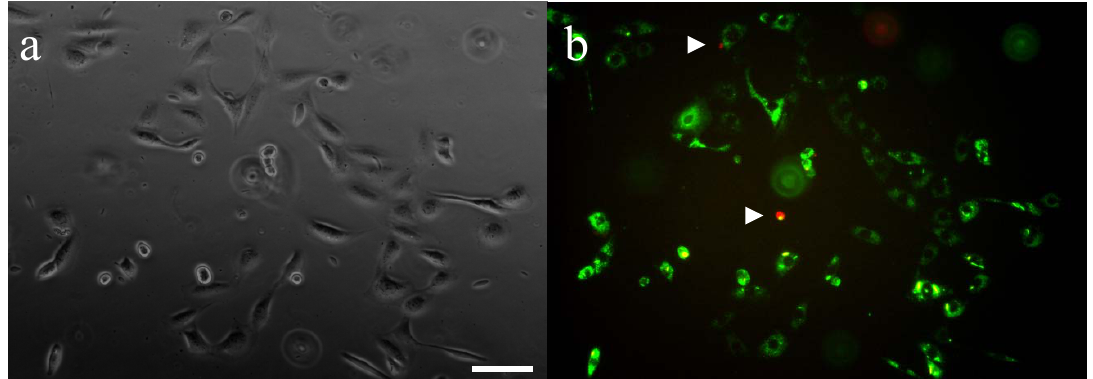
Figure 6. The morphology and viability of fibroblasts cultured for 24 h on RGD-modified 12:8% CMC-methacrylate/% PEG-DM gel substrates. Fibroblasts adherent to the gel surface imaged under (a) phase contrast to view cell morphology and (b) fluorescence microscopy to analyze the viability of cells stained with calcein (green) to label live cells and ethidium homodimer-1 (red; arrowheads) to label dead cells. Scale, 100 μ